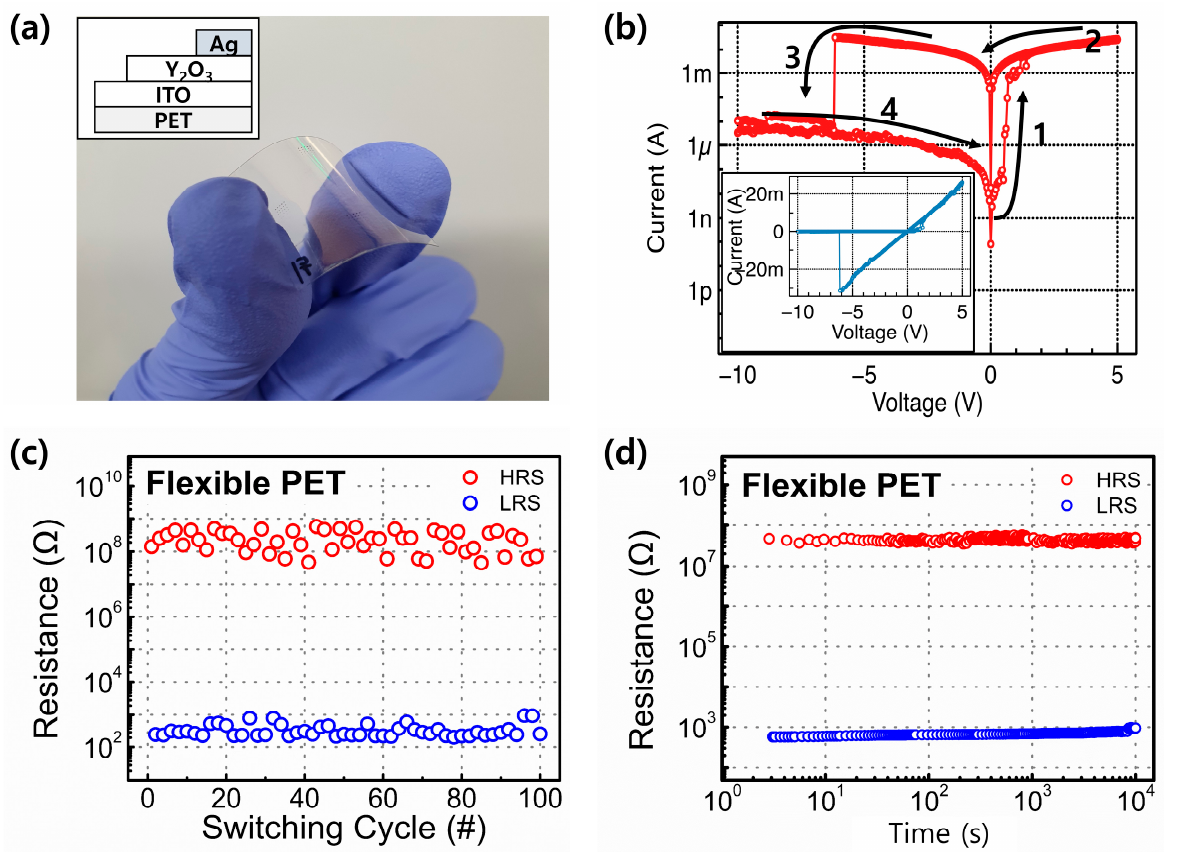
Figure 9. ( a ) Optical image of a fabricated flexible ITO/Y 2 O 3 /Ag RRAM device. Inset shows a schematic of the fabricated devices. ( b ) Representative I–V curve in the log scale. Inset shows an I–V curve in the linear scale. Arrows and numbers indicate the voltage bias directions, ( c ) endurance, and ( d ) retention properties of the devices.